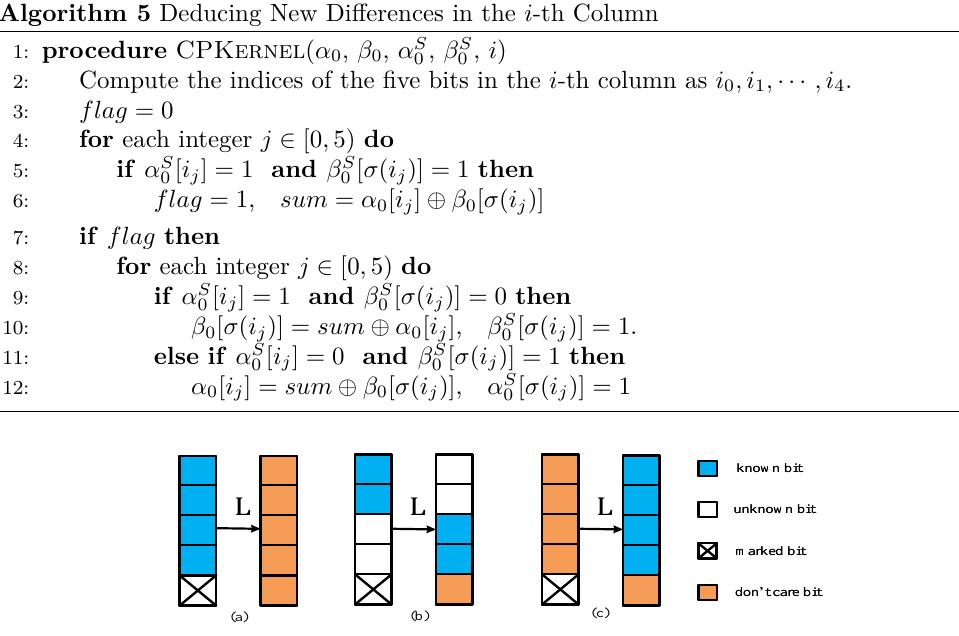
Figure 6: Representatives when the sum state is